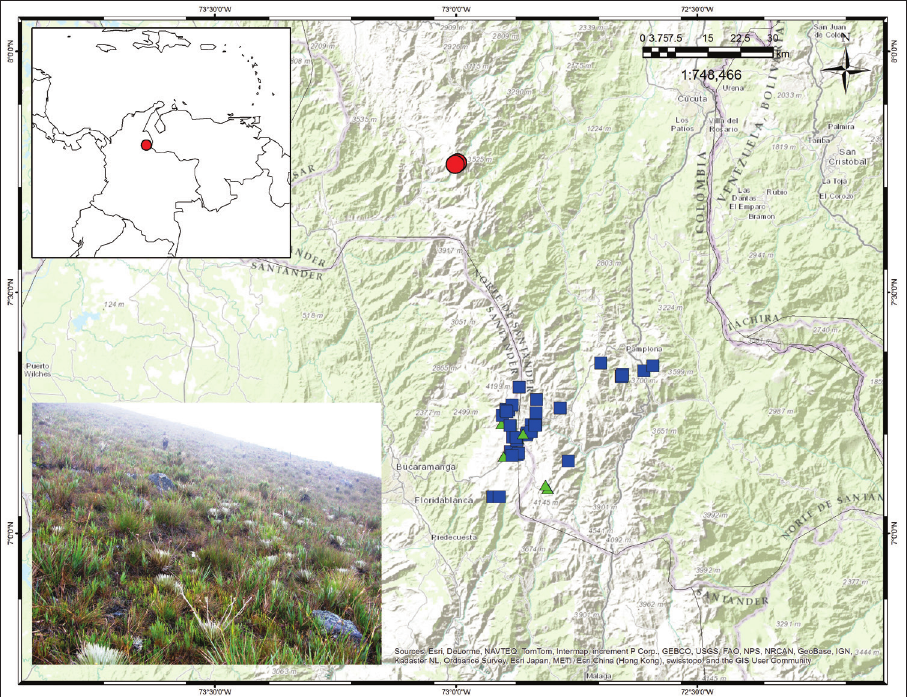
Figure 4. Distribution map showing collections for Espeletiopsis diazii (red circles), E. santanderensis (blue squares) and E. caldasii (green triangles). Photograph of the Páramo de Cáchira, with a population of E. diazii